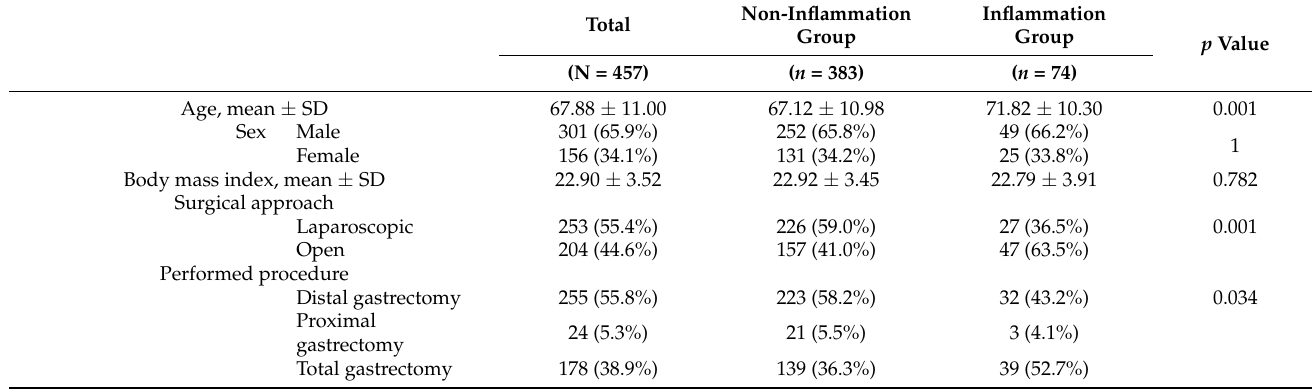
Table 2. Patient